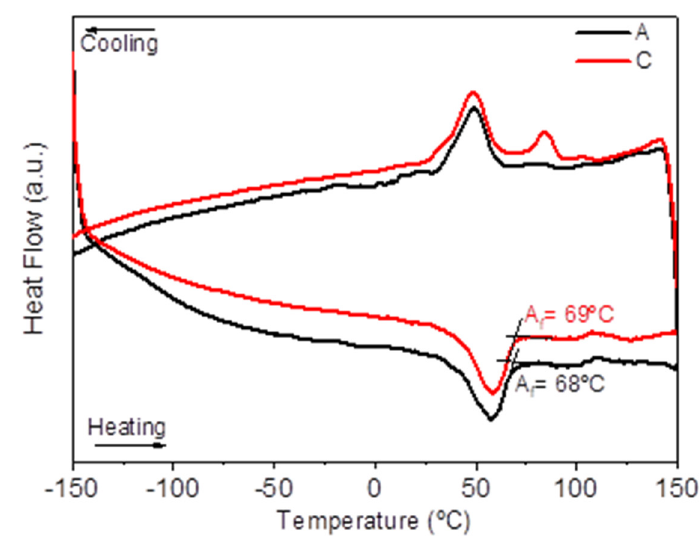
Figure 9. DSC curves of 3D objects from filaments A and C (addition of 5 wt.% TiH 2 ). X-ray diffractograms corroborate the SEM results in the apparent disappearance of the Ni 3 Ti phase. Moreover, they suggest the possibility that Ti, resulting from dehydrogenation, may have contributed to the formation of NiTi. The XRD results also support the possible reaction of free Ti resulting from dehydrogenation with free Ni present in the virgin powder, since Ni is not identified in the x-ray diffractograms (Figure 10).